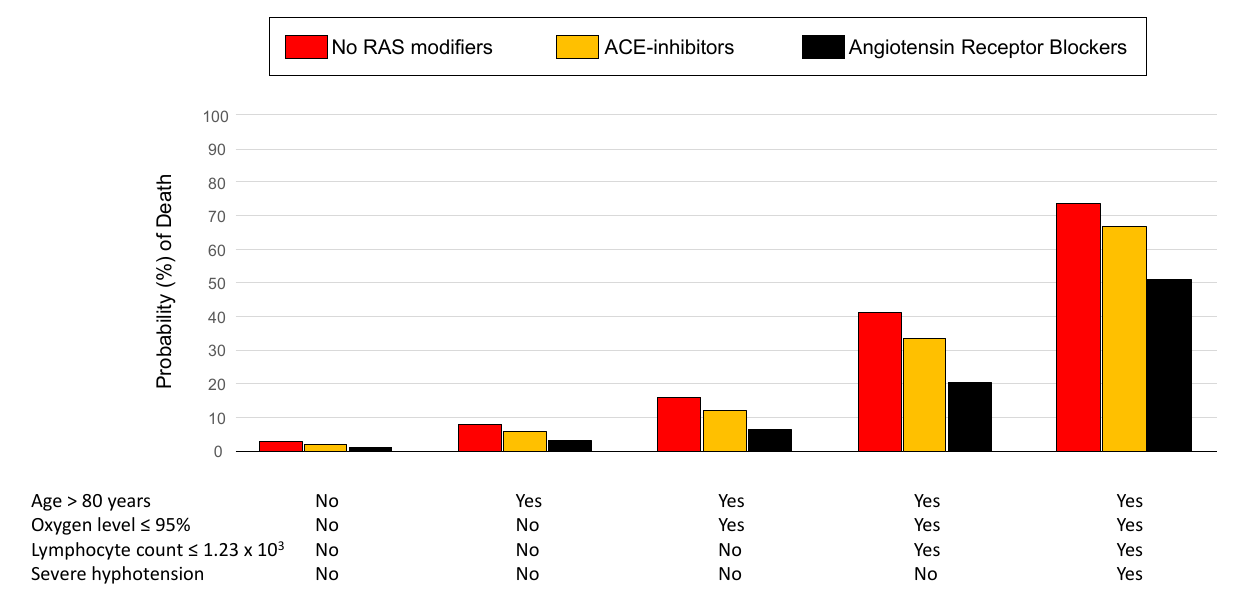
Figure 3. Effects of different blood pressure-lowering drugs on the probability (%) of in-hospital death according to different baseline risk strata (as identified by the presence of independent risk markers of prognosis).